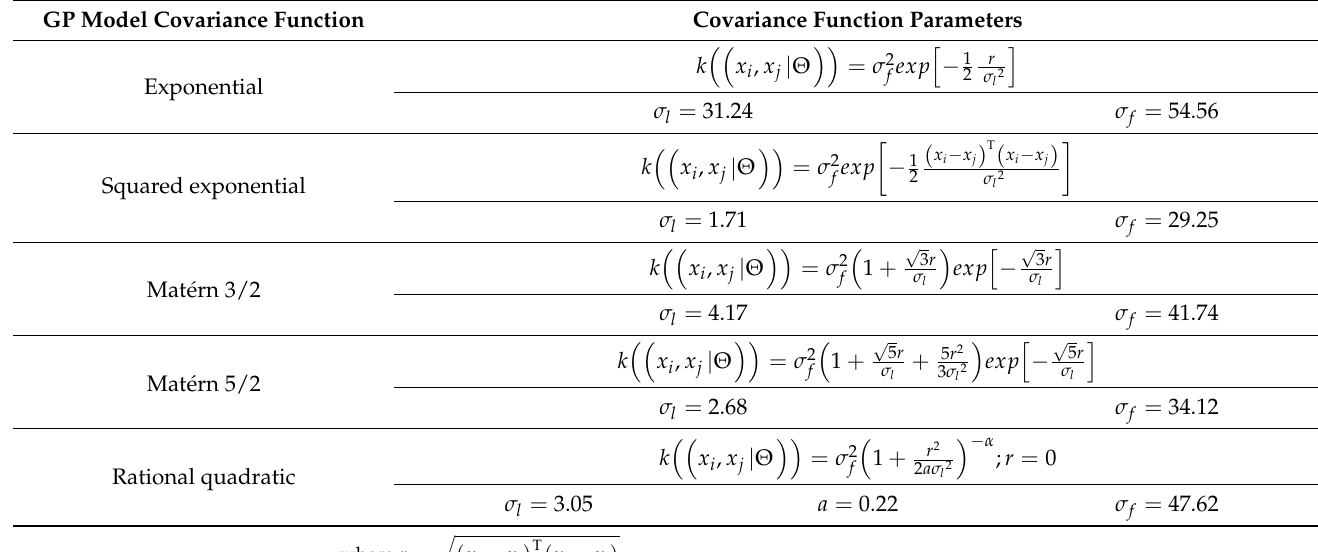
Table 7. Values of optimal parameters in GPR models with different covariance functions.